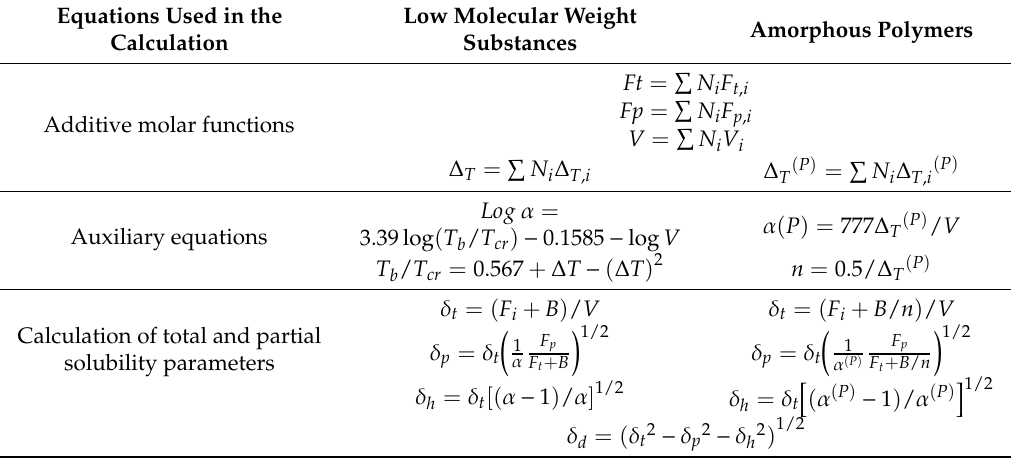
Table 2. The equations used for the estimation of the solubility parameter and its components in Hoy’s (1985) group contribution system